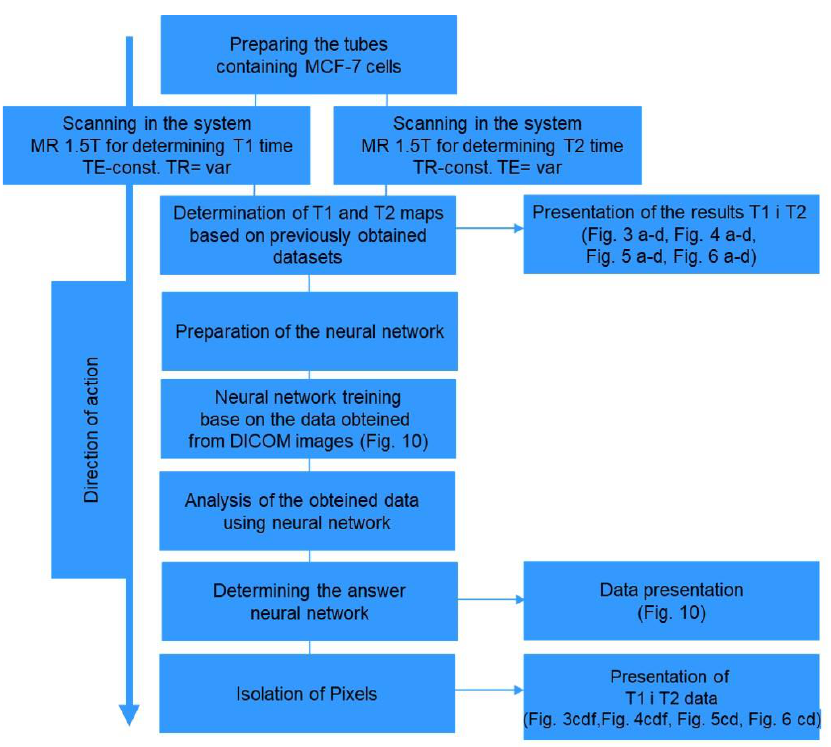
Figure 8. The algorithm of performed